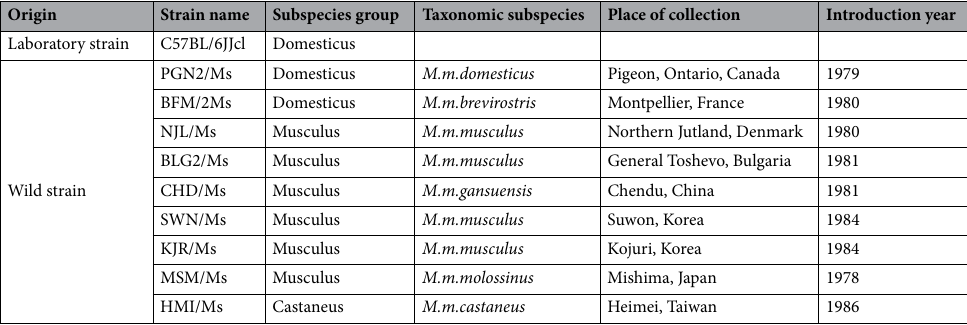
Table 1. List of strains used in the